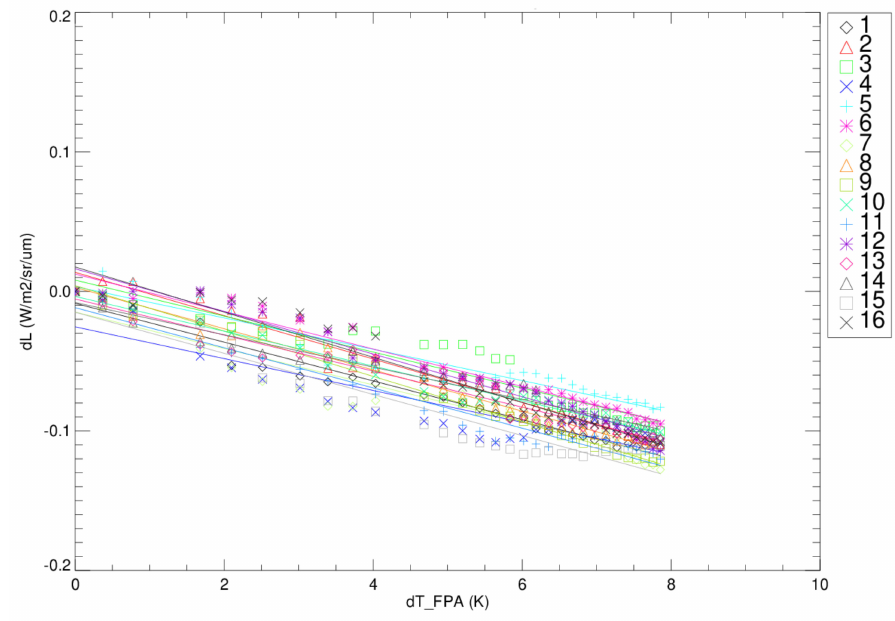
Figure 15. Band M1 temperature sensitivity (dL) as a function of focal plane assembly (FPA) tempera- ture change between nominal and hot plateau for each detector (colors and